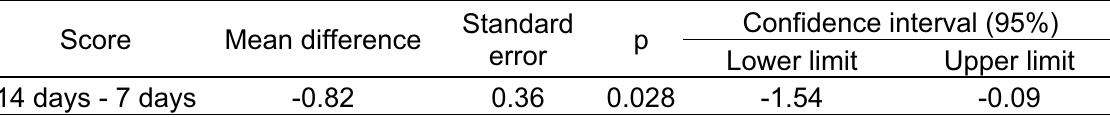
TABLE 12 – Mean difference in scores between groups of animals reoperated on 14 or seven days after the first